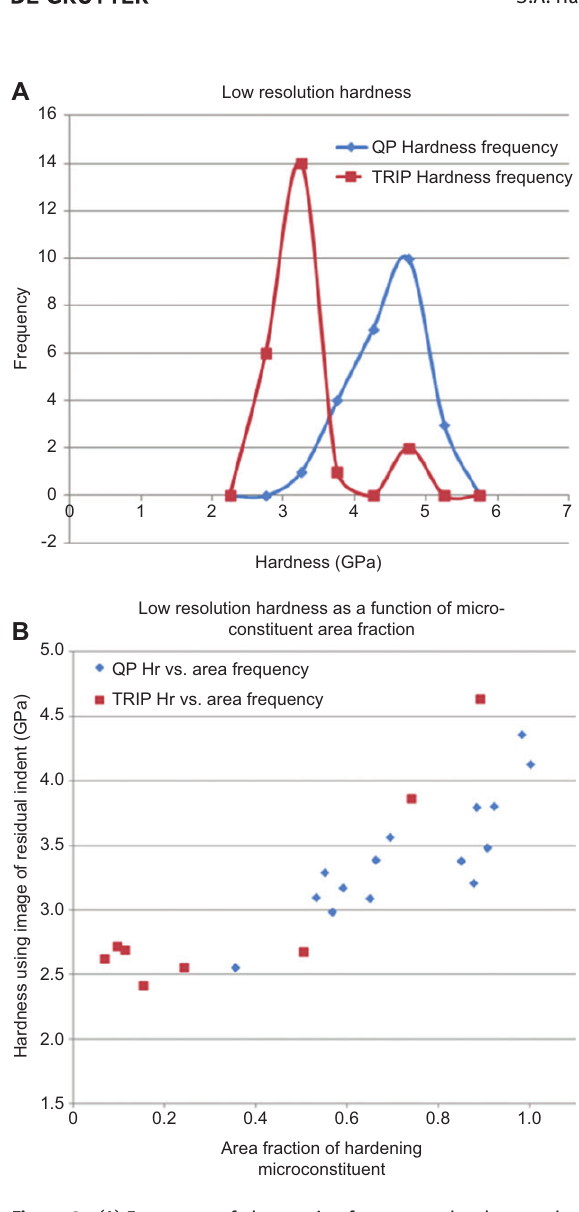
Figure 2 (A) Frequency of observation for average hardness values as determined over the entire depth of indentation, with maximum indentation depth at 1.1 μ m. (B) Low-resolution hardness for TRIP and QP as a function of area fraction of microconstituent that is not ferrite